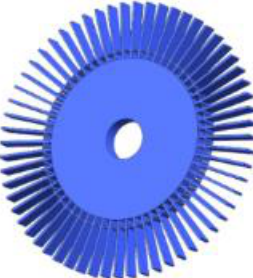
Figure 1. Dummy bladed disk for vibration analysis.